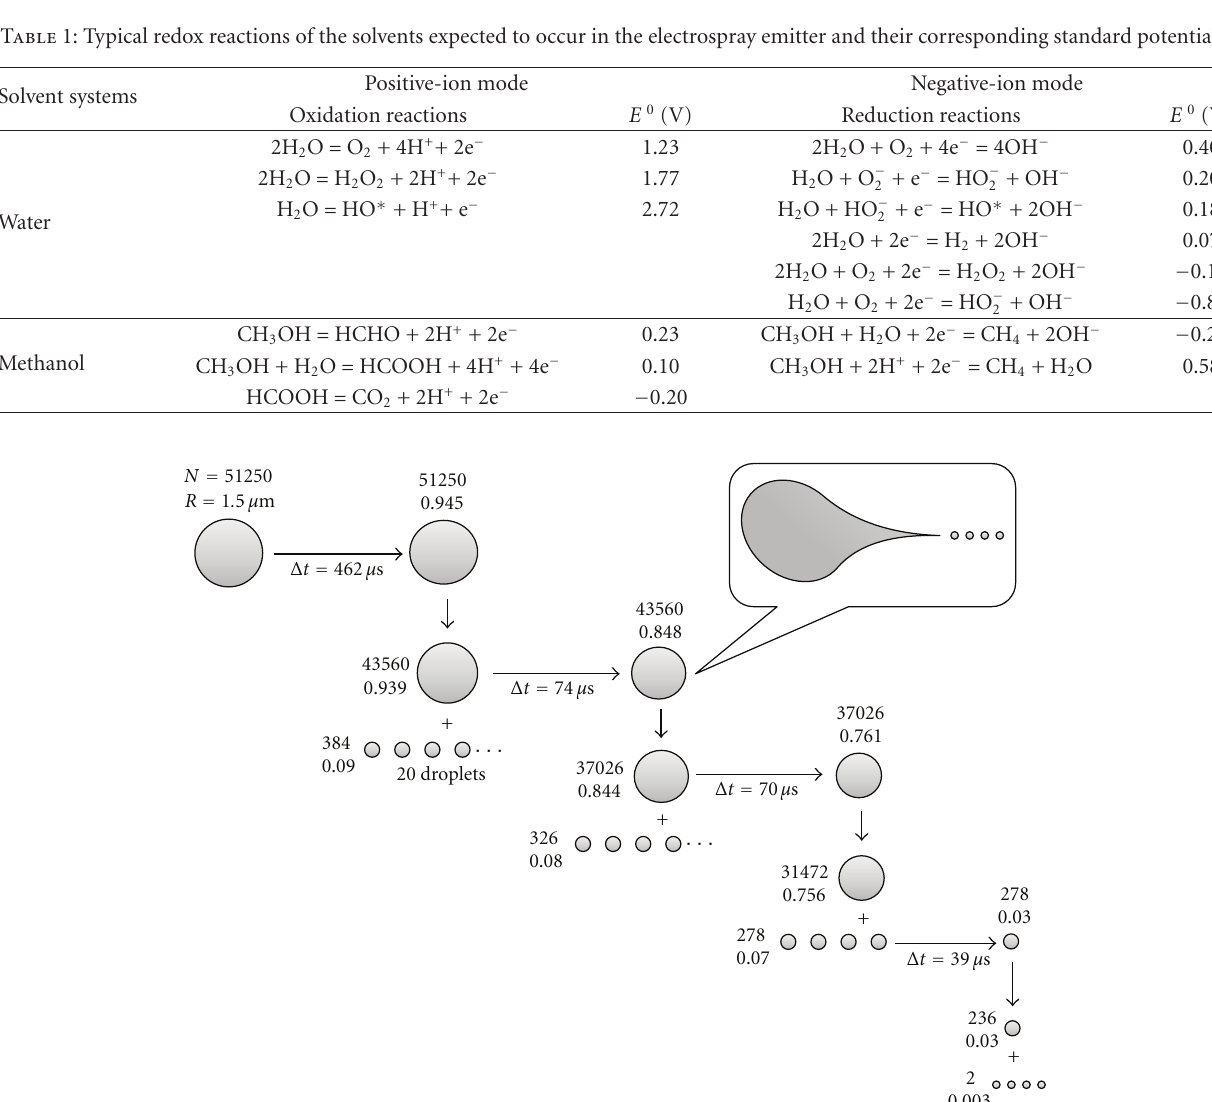
Figure 7: Time history of the charged methanol droplet produced by microelectrospray process. The droplet at the top left is a typical parent droplet created at the ES capillary tip. The successive solvent evaporation and Coulomb fission leads to the charged nanodroplets that are the precursors of the gas-phase analyte ions. The numbers beside the droplets give radius R ( μ m) and number of elementary charges N on the ES droplet; Δ t corresponds to the time required for evaporative droplet shrinkage to size where fission occurs. Only the first three successive fissions of a parent droplet are shown. At the bottom right, the fission of the o ff spring droplet to produce the charged nanodroplets is shown. The inset shows a drawing of droplet jet fission based on actual flash microphotograph. (Adapted with permission from [22], Copyright 1993, American Chemical